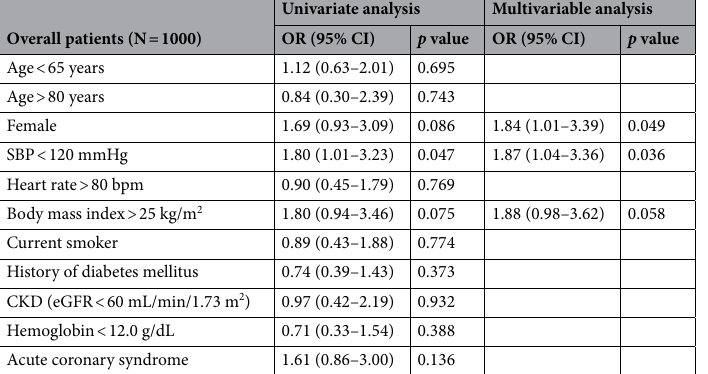
Overall patients (N =